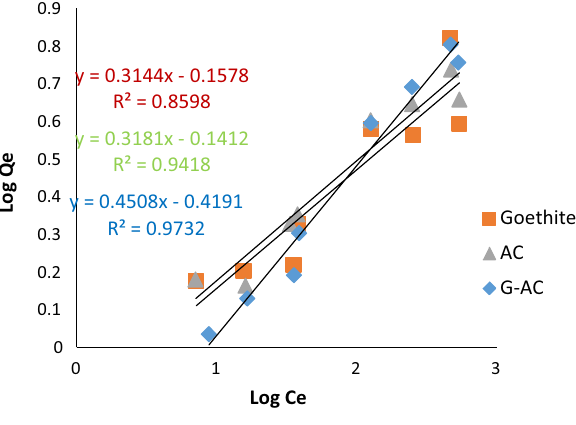
Table 2 Isotherms parameters for various Cr(VI) adsorption systems Adsorption models Isotherms param- eters